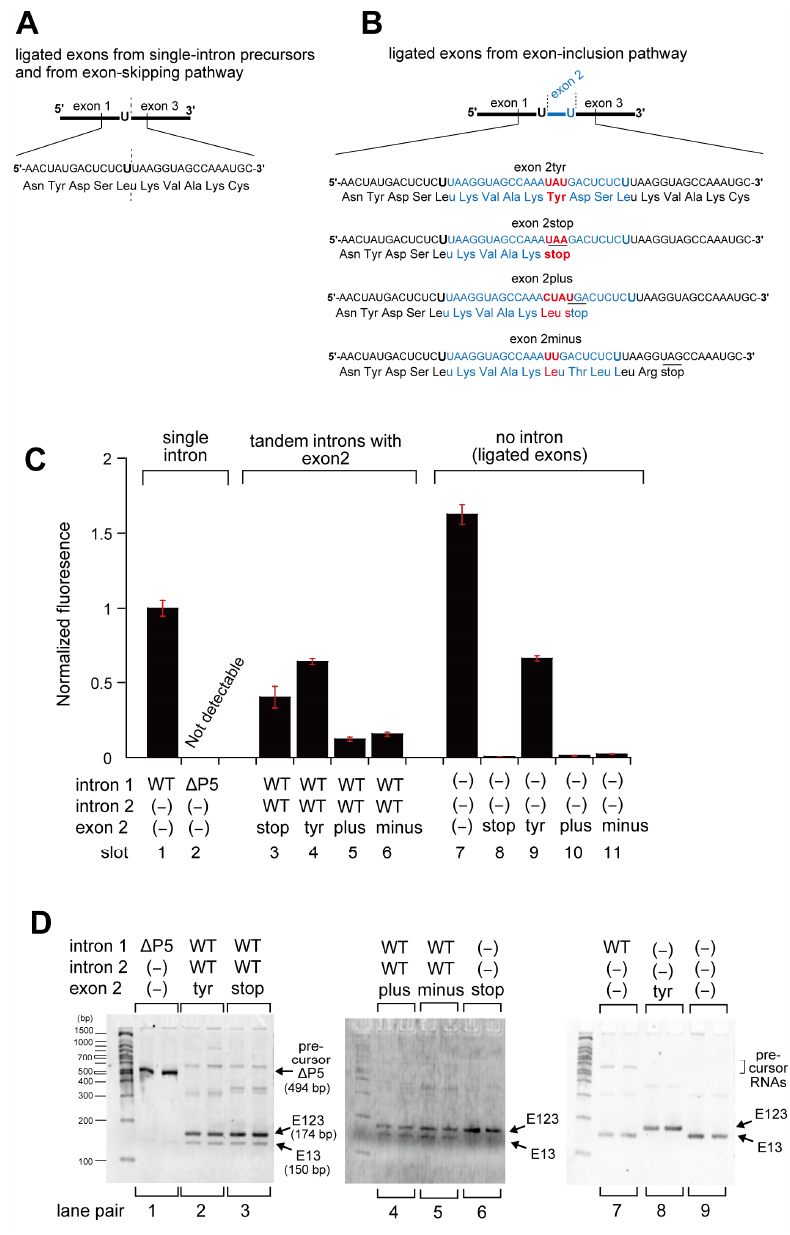
Figure 2. Splicing patterns of precursor RNAs possessing two Tetrahymena introns. ( A ) Ligated exons from single-intron precursors and exon-skipping splicing. The corresponding amino acid sequence is also shown. ( B ) Ligated exons from exon-inclusion splicing. Four exon 2 sequences were used in this study. The corresponding amino acid sequences are also shown. ( C ) β-Galactosidase reporter gene assays to evaluate the splicing activities of the precursors with a single WT or ∆P5 intron and four precursors with two introns and a short exon (exon 2) in E. coli . Expression of the lacZ-α fragment was also measured from the ligated exons without or with exon 2. ( D ) RT-PCR assays to distinguish the ligated exons (E123 or E13) including or skipping exon 2, with lengths of 174 and 150 bp, respectively. As the ∆P5 mutant was splicing-deficient in E. coli , the RT-PCR product corresponded to the precursor RNA.